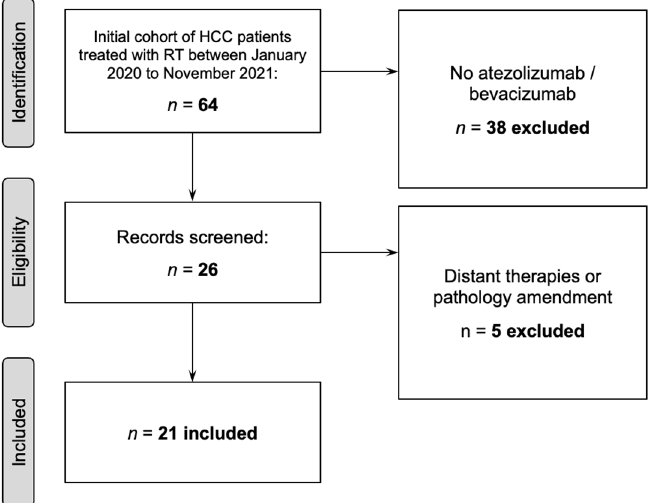
Figure 1. Patient inclusion and exclusion criteria. Abbreviations: RT = radiation therapy.